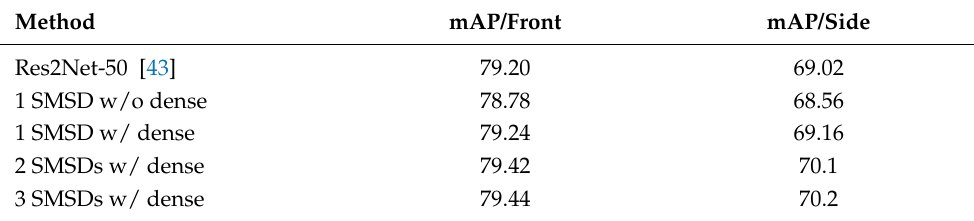
Table 2. Component analysis. “Front” and “Side” denote the front- and side-view images. The accu- racy was improved with the increase in the number of SMSD blocks. “1 SMSD w/o dense” means that the dense connections from m 1, m 2, m 3 and m 4 to p 1 and p 2 in the SMSD block were